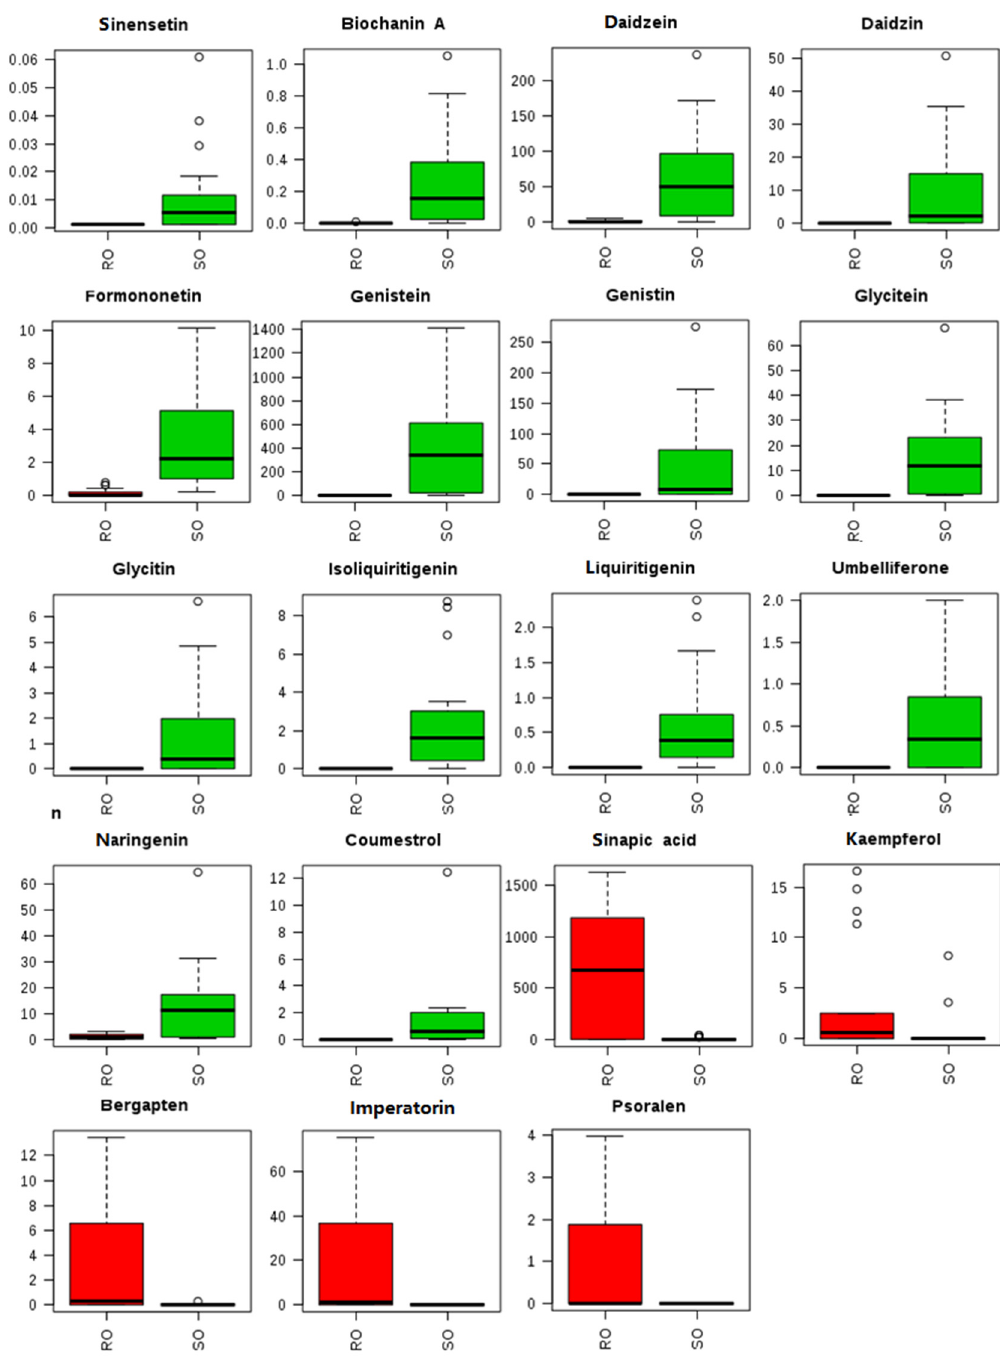
Figure 2. Boxplot of the concentrations of markers in RO and SO (ng/g).